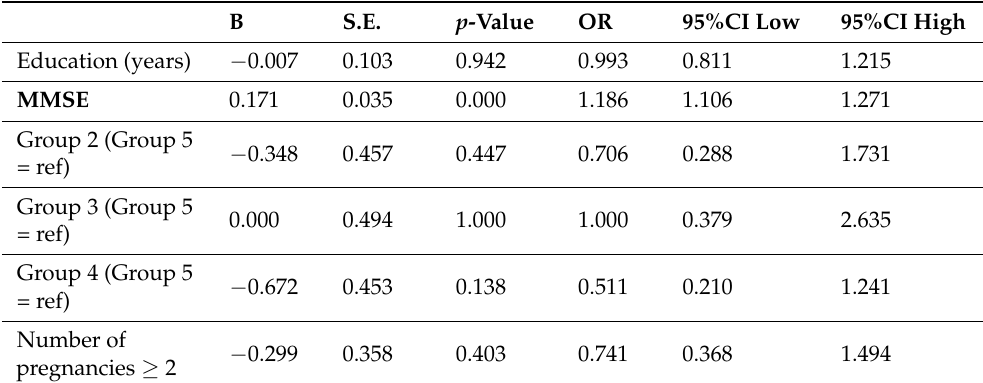
Table 3. Logistic regression analysis; association between occupational group and functional inde- pendence (no Basic Activities of Daily Living